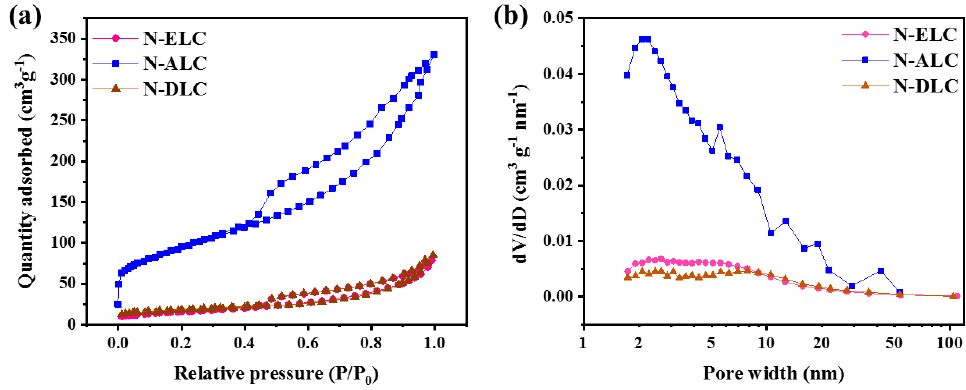
Figure 7. ( a ) N 2 adsorption–desorption isotherms of different lignin carbon materials. ( b ) Aperture distribution